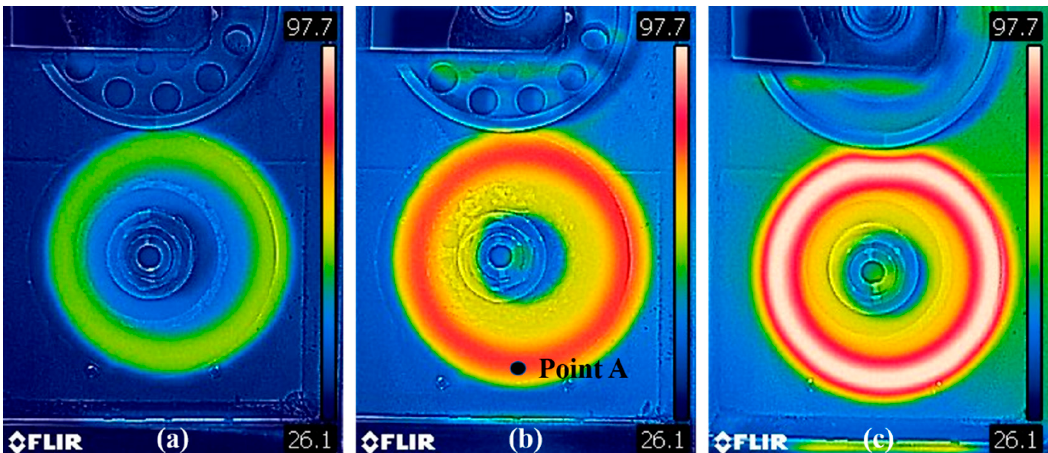
Figure 14. Steady-state surface temperature distribution of the solid tire recorded by an infrared camera under different boundary conditions ( a ) 15 kg and 600 rev/min, ( b ) 30 kg and 600 rev/min, ( c ) 30 kg and 1200 rev/min.